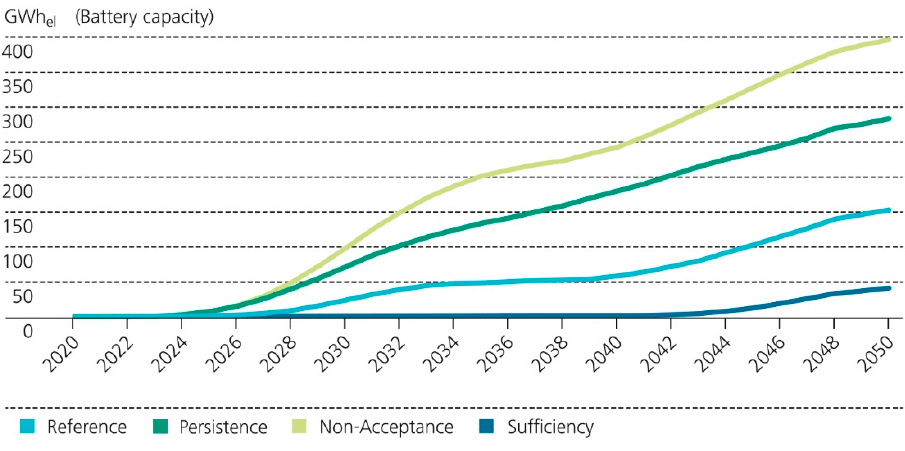
Figure 5. Installed capacity of stationary batteries in Germany for all calculated scenarios.